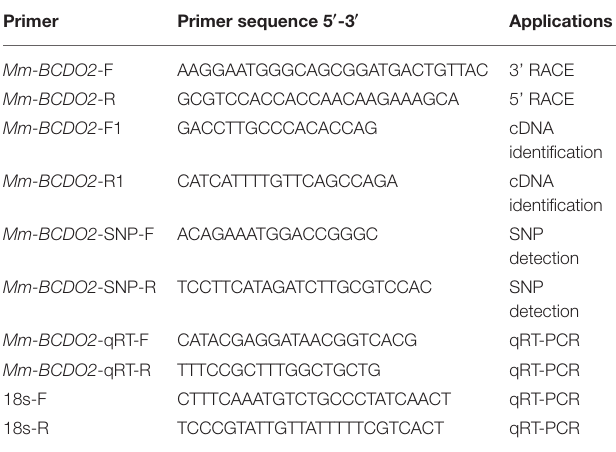
TABLE 1 | Primers and sequences used in this experiment.